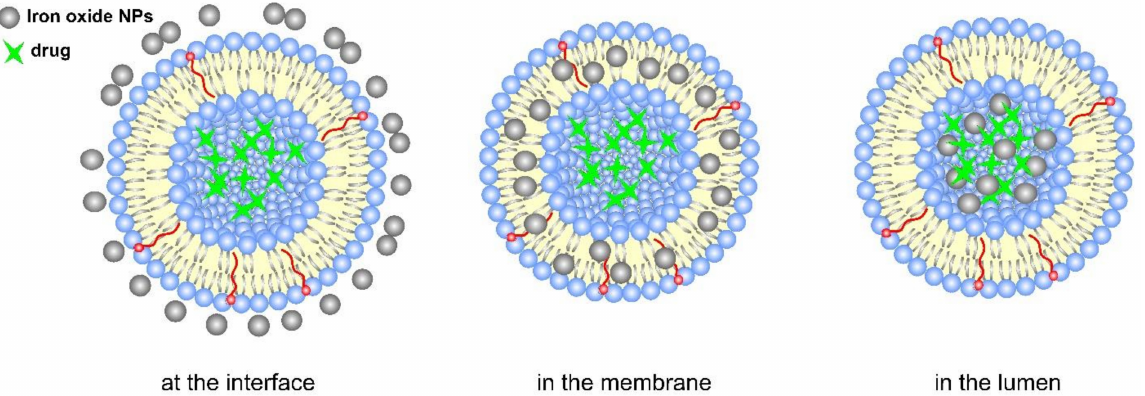
Figure 12. Schematic representation of different types of incorporation of iron oxide NPs in responsive liposomes for targeted therapy with radiofrequency/magnetic